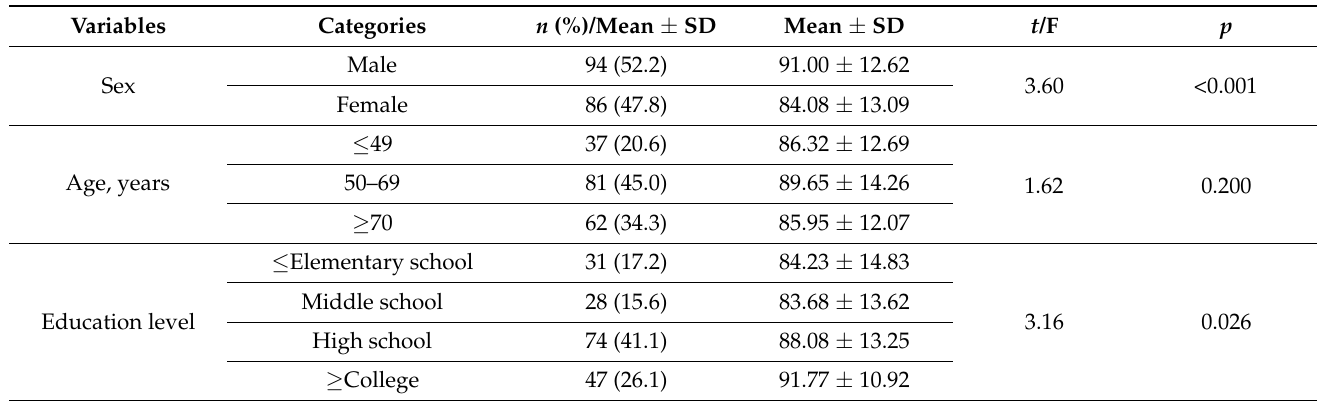
Table 1. Comparison of quality of life according to general characteristics ( n =